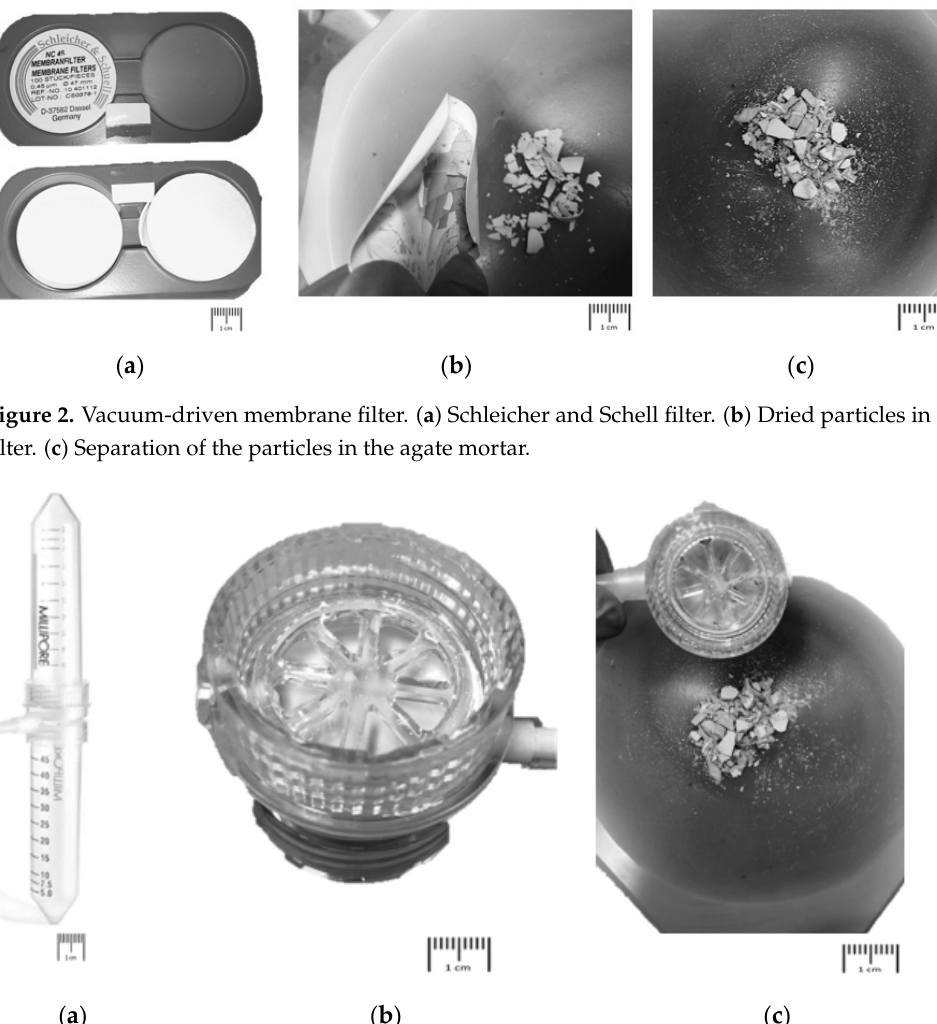
Figure 2. Vacuum-driven membrane filter. ( a ) Schleicher and Schell filter. ( b ) Dried particles in the filter. ( c ) Separation of the particles in the agate mortar.